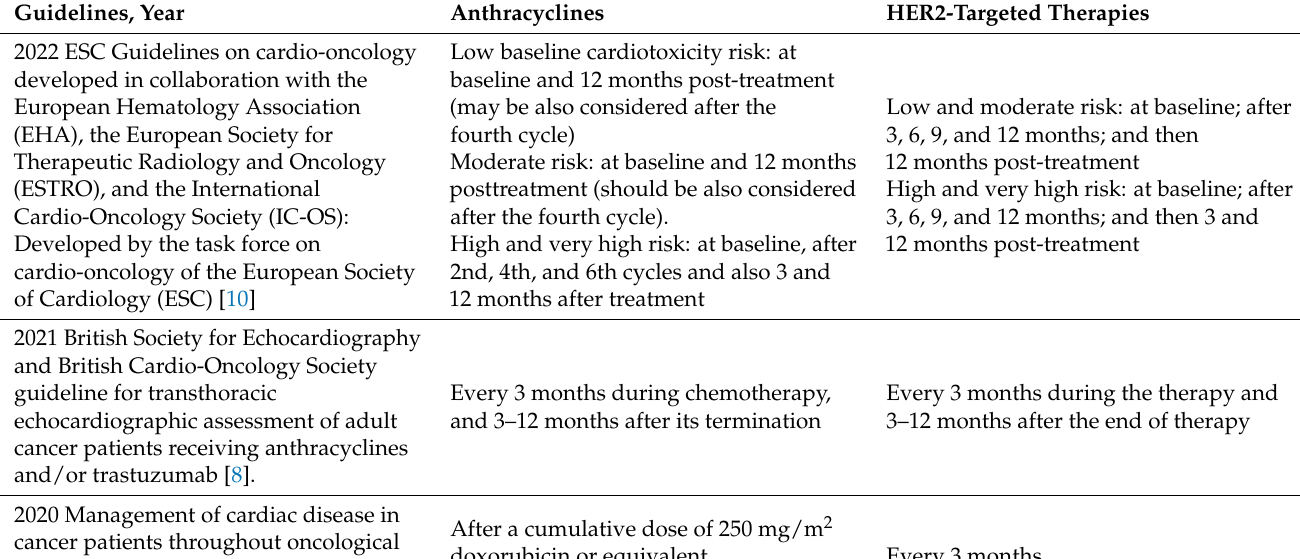
Table 1. Recommendations of scientific societies in recent years regarding the frequency of performing an echocardiographic examination with a GLS